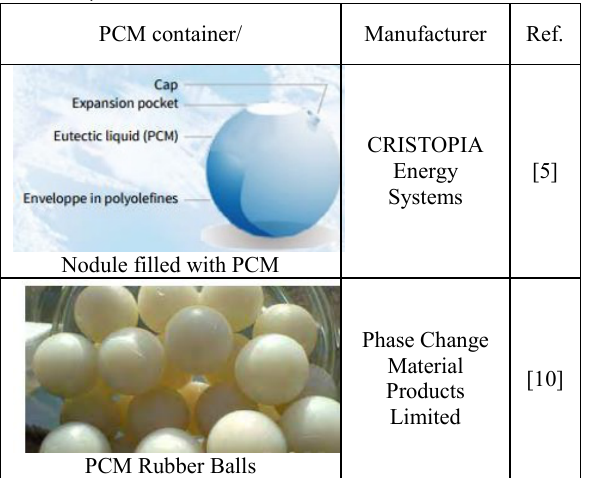
Table 2 Examples of commercially available containers and macrocapsules filled with PCMs